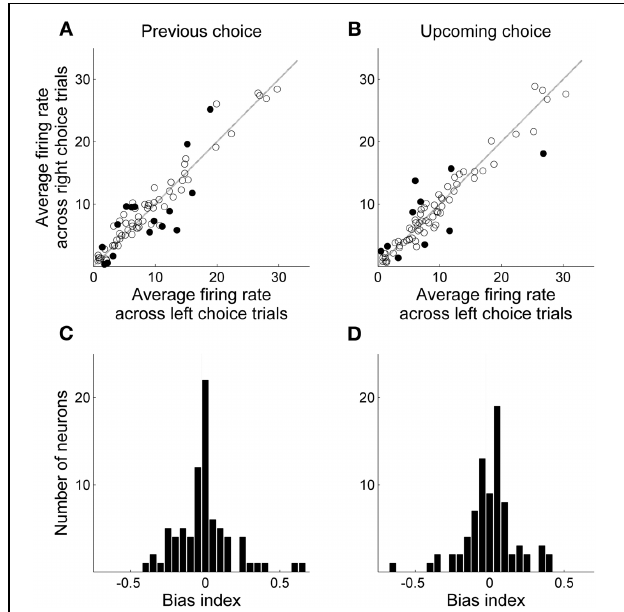
FIGURE 4 | Mean delay-period activity of MDN units associated with left and right goal choices. All trials were divided into two groups according to the animal’s previous ( A and C ) or upcoming ( B and D ) goal choice and mean discharge rates during the entire delay period were averaged across trials within each group for each neuron. (A,B) Scatter plots relating averaged delay-period activity of individual neurons for the left and right goal choices. Filled circles denote those neurons for which average firing rates during the delay period were significantly different between left and right choices ( t -test, alpha = 0.05). (C,D) Frequency histograms for the bias